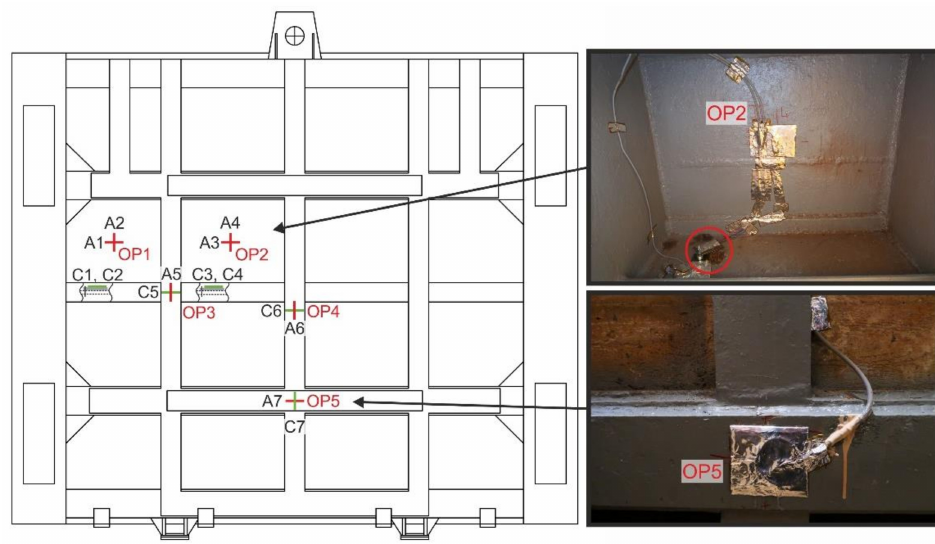
Figure 11. Application points of strain gauges for operational measurement.